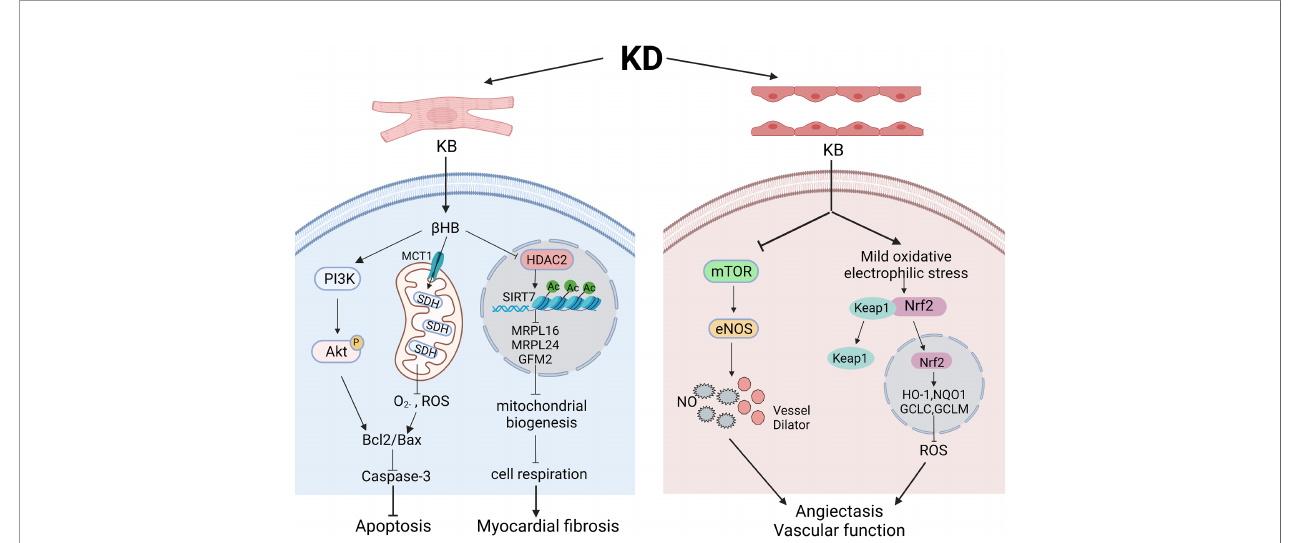
FIGURE 2 | The role and mechanism of ketogenic diets in cardiac function and vascular function. Various pathways might underly the effects of ketogenic diets in cardiomyocytes and endothelial cells in different models. In cardiomyocytes, b HB regulates PI3K/Akt pathway and SDH in mitochondria to fi nally ameliorate cell apoptosis. However, elevated b HB might also acts through inhibiting HDAC2 and in fl uencing mitochondrial biogenesis, leading to myocardial fi brosis. In endothelial cells, ketone bodies can functions through inhibiting mTOR pathway to regulate the level of eNOS, subsequently dilating blood vessels and enhancing vascular function. Besides, elevated ketone bodies can give rise to mild oxidative/electrophilic stress, activate Nrf2 in cytoplasm and enhance antioxidant gene expression, which lead to lowered ROS level and improved vascular functions. Created with